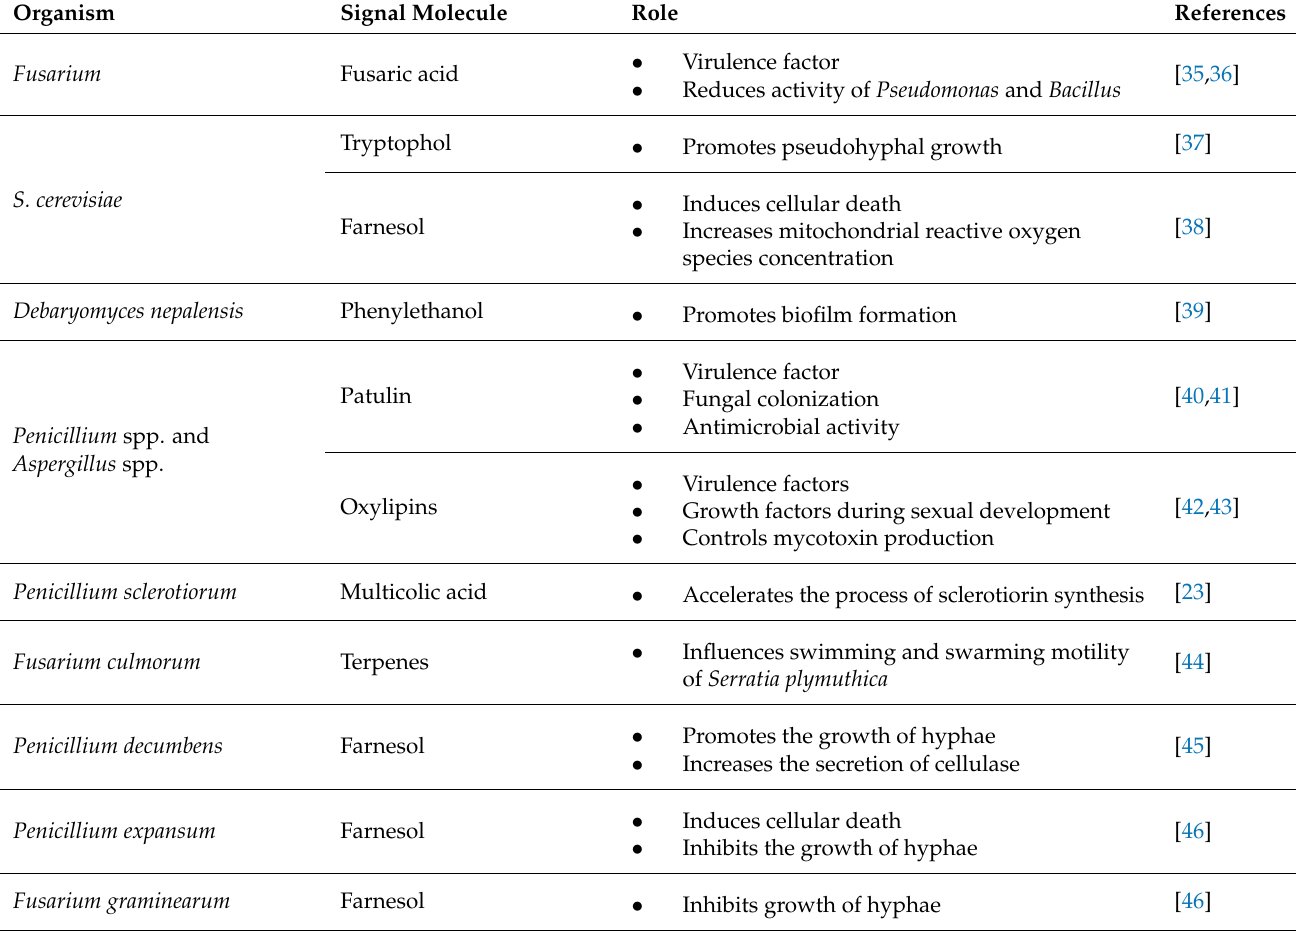
Table 1. Signal Molecule Produced by Fungi and the